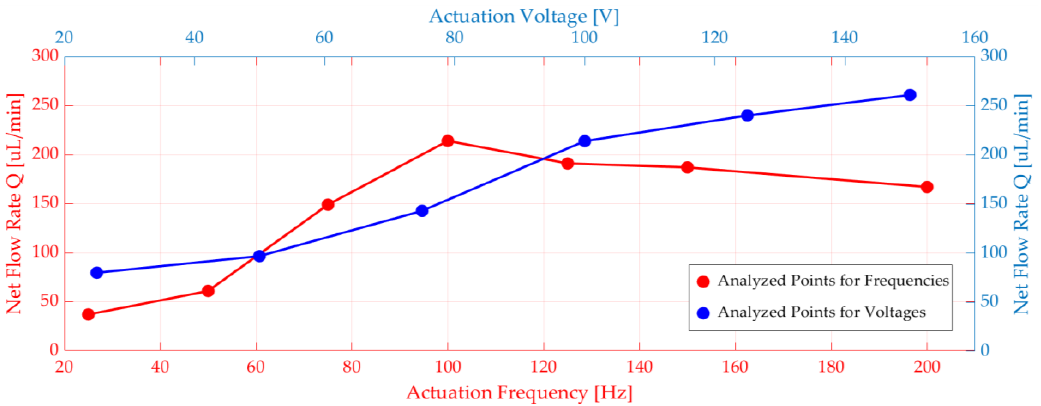
Figure 5. Numerical simulations of net flow rate versus voltage and frequency.